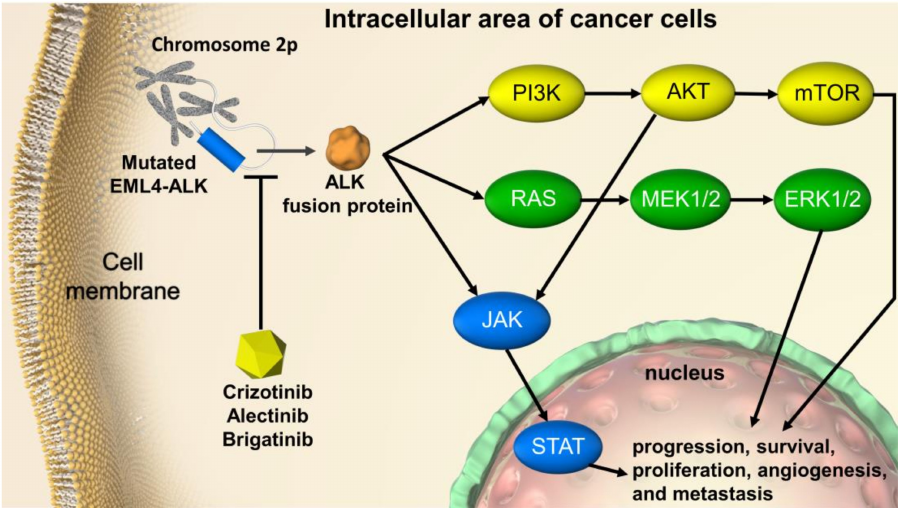
Figure 1. ALK-rearrangement-targeted cancer therapy in non-small cell lung cancer. EML4-ALK translocation activates PI3K-AKT, RAS, and JAK / STAT signaling cascades, thereby influencing tumor progression, survival, and growth. ALK inhibitors such as crizotinib, alectinib, and brigatinib act on mutated ALKs, such as ELM4-ALK, and suppress the production of ALK fusion protein resulting from ALK rearrangement. EML4-ALK, echinoderm microtubule-associated protein-like 4-anaplastic lymphoma kinase; ALK, anaplastic lymphoma kinase; PI3K, phosphatidylinositol-3 kinase; mTOR, mammalian target of rapamycin; RAS, reticular activating system; MEK, mitogen- activated extracellular signal regulated kinase; ERK, extracellular signal-regulated kinase (ERK); JAK, Janus kinase; STAT, signal transducer and activator of